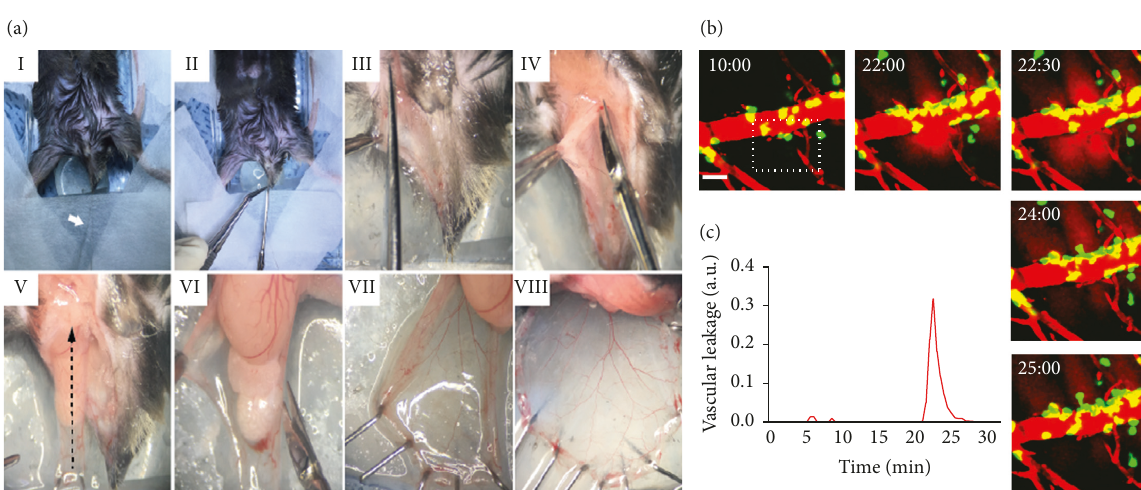
Figure 1: Cremaster surgery and intravital imaging of inflamed cremaster vessel. (a) (I) The body of the mouse was fixed in a chamber, using surgical tape, with traction on the scrotum using suture thread. (II) The scrotum was cut with scissors after filling the chamber with sterile 1x PBS. (III) The epidermis in the scrotum was cut along its edge. (b, c) Changes in vessel permeability with time (min) were observed using intravital imaging. Vascular leakage was measured as an arbitrary unit. An intact vessel with zero leakage was set as the baseline for this unit. A graph of vascular leakage shows local and transient increase in blood permeability. Scale bar: 30 µ m. See Video